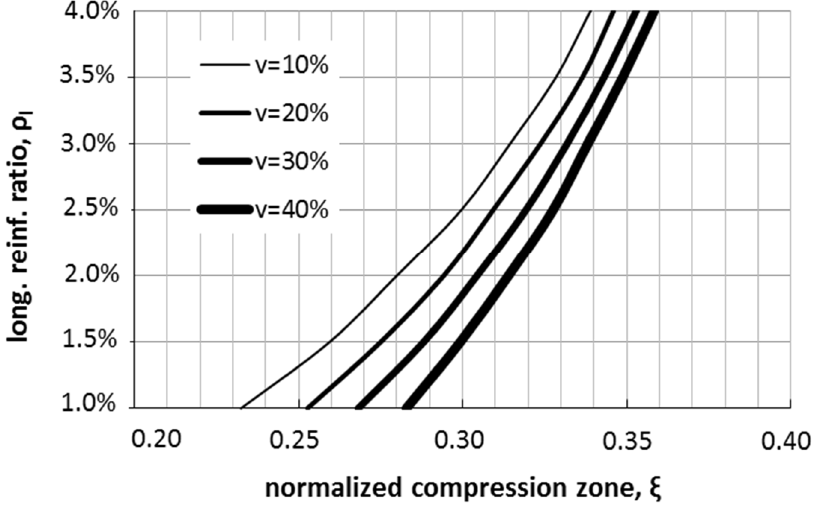
Figure 3. Estimation of compression zone depth at ultimate for symmetrically reinforced concrete cross section with variables being the axial load and the amount of reinforcement. Table 1. Results from cross section analysis and rotation capacity.